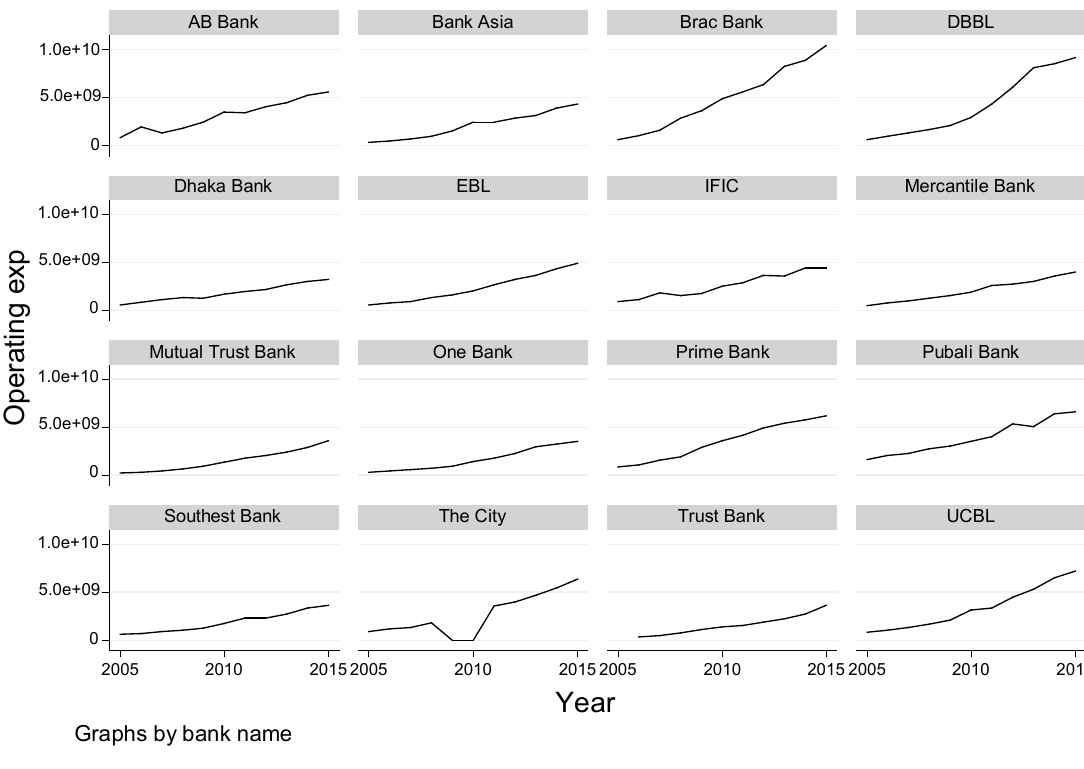
Figure 10. Comparison of the operating expenses from the period 2005 to 2015